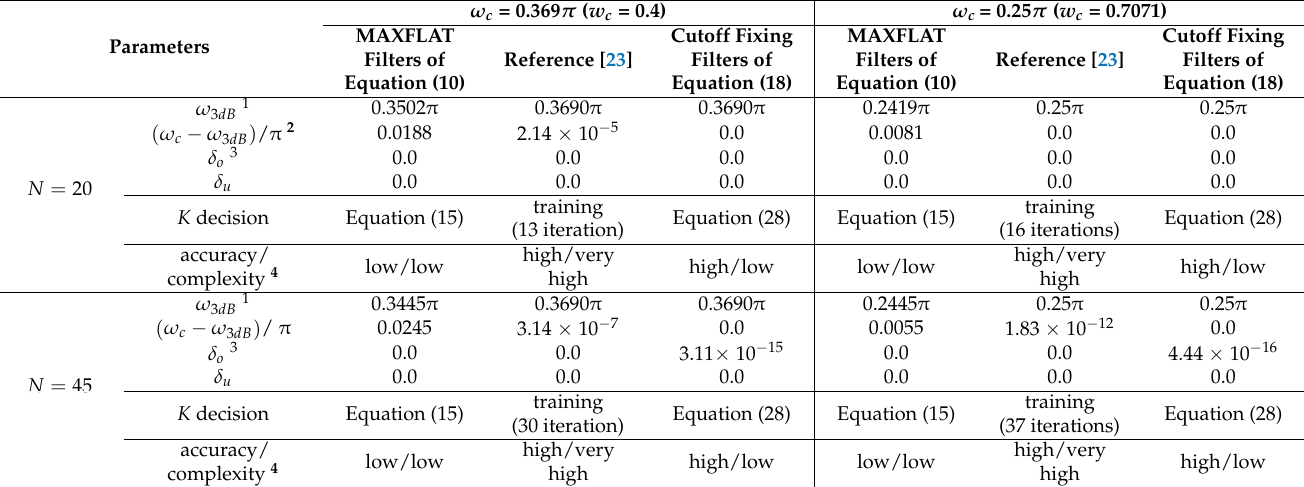
Parameters Table 3. Comparison of three design methods for (a) N = 20 and (b) N = 45.